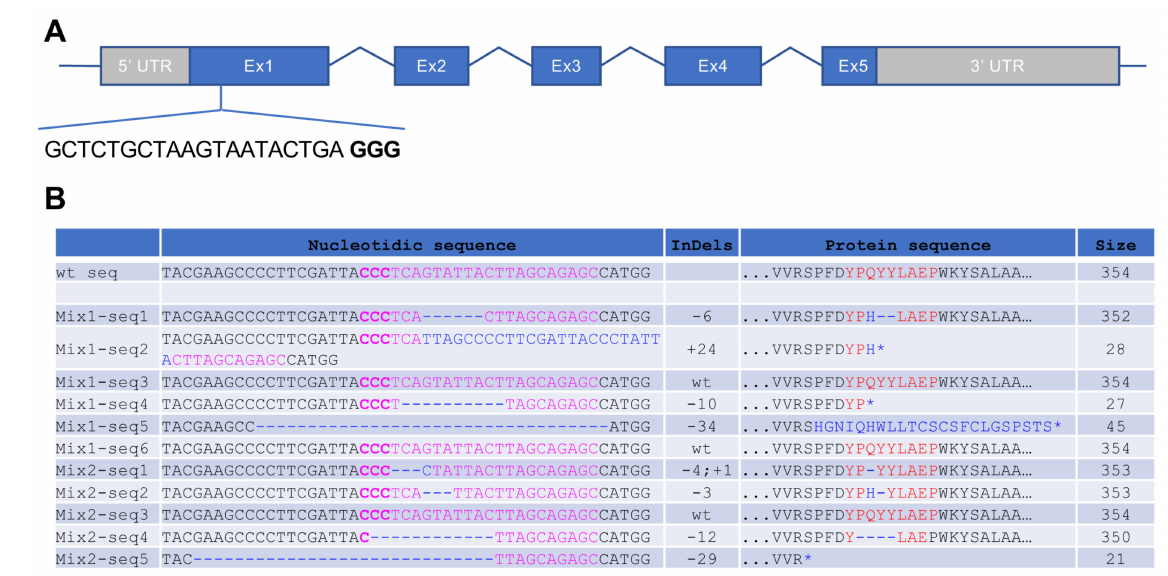
Figure 1. Genomic analysis of X. tropicalis rho crispants. ( A ) Schematic of the Xenopus tropicalis rho gene. The depicted sequence corresponds to the CRISPR RNA targeting exon 1 and to the protospacer adjacent motif (PAM; indicated in bold). ( B ) Sequences obtained from individual clones of PCR products amplified from genomic DNA. Two mixtures (Mix1, 2) of 5 X. tropicalis F0 embryos injected with 500 pg of rho sgRNA and 600 pg of cas9 mRNA were used. For each clone, the targeted sequence is shown in pink, with PAM in bold, while indels are in blue. The right column indicates the corresponding protein sequence and its size (number of amino